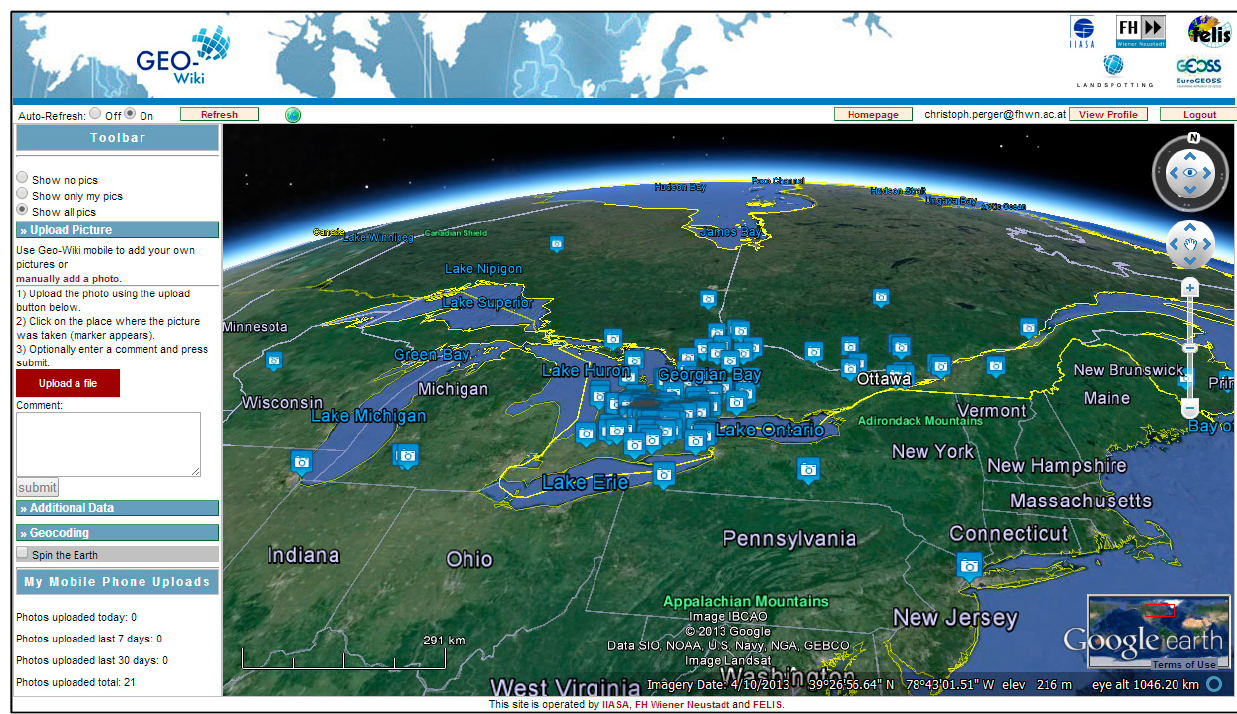
Figure 1. The Geography Geo-Wiki user interface for the photo assignment type, with picture markers from the whole group in the Great Lakes